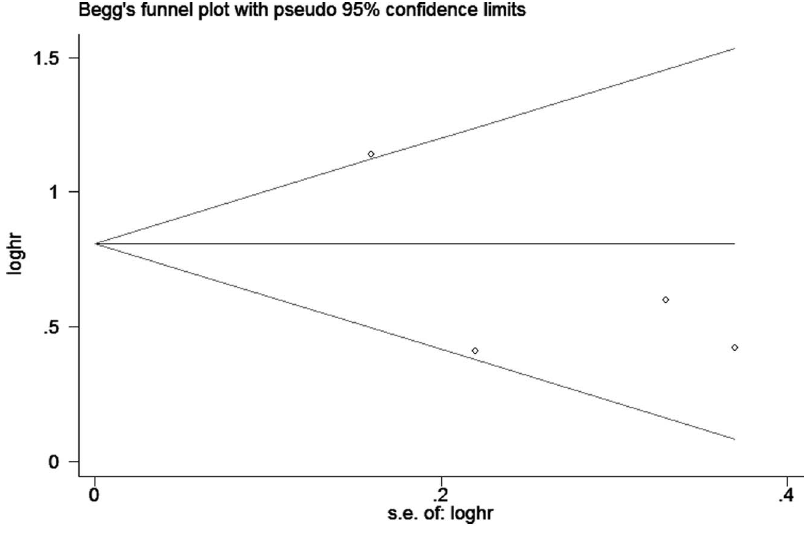
Fig. 4. Begg’s funnel plot of publication bias of hazard ratio for overall survival in the meta-analysis. The funnel plot displays log HR against its standard error (s.e.) for each individual study. The horizontal line represents the estimate of the overall HR, with the dash lines indicating the expected 95% CI for a given standard error. No evidence of publication bias was observed in the